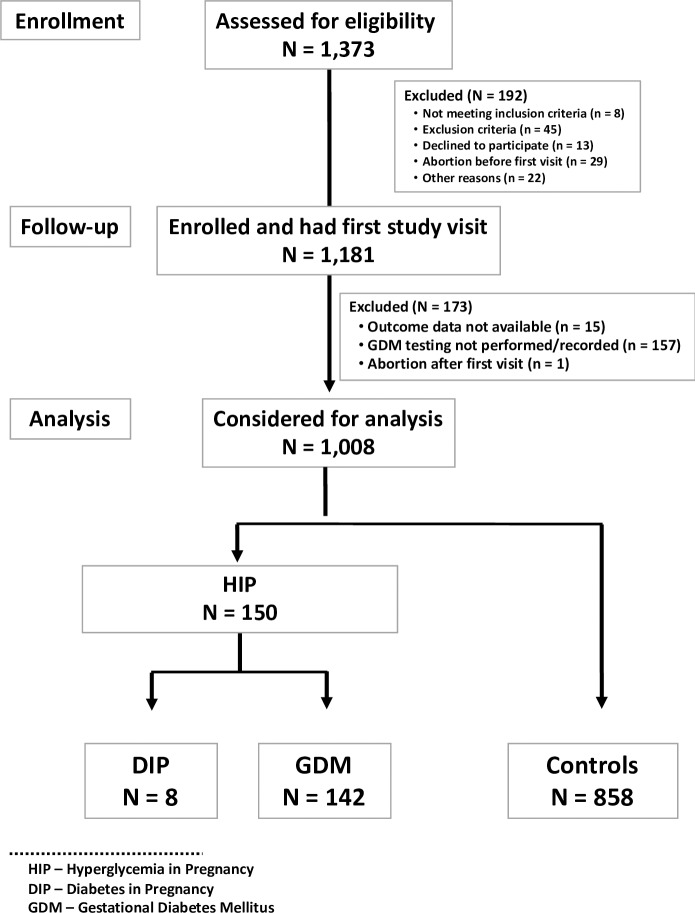
Flow chart of participating women in the study.